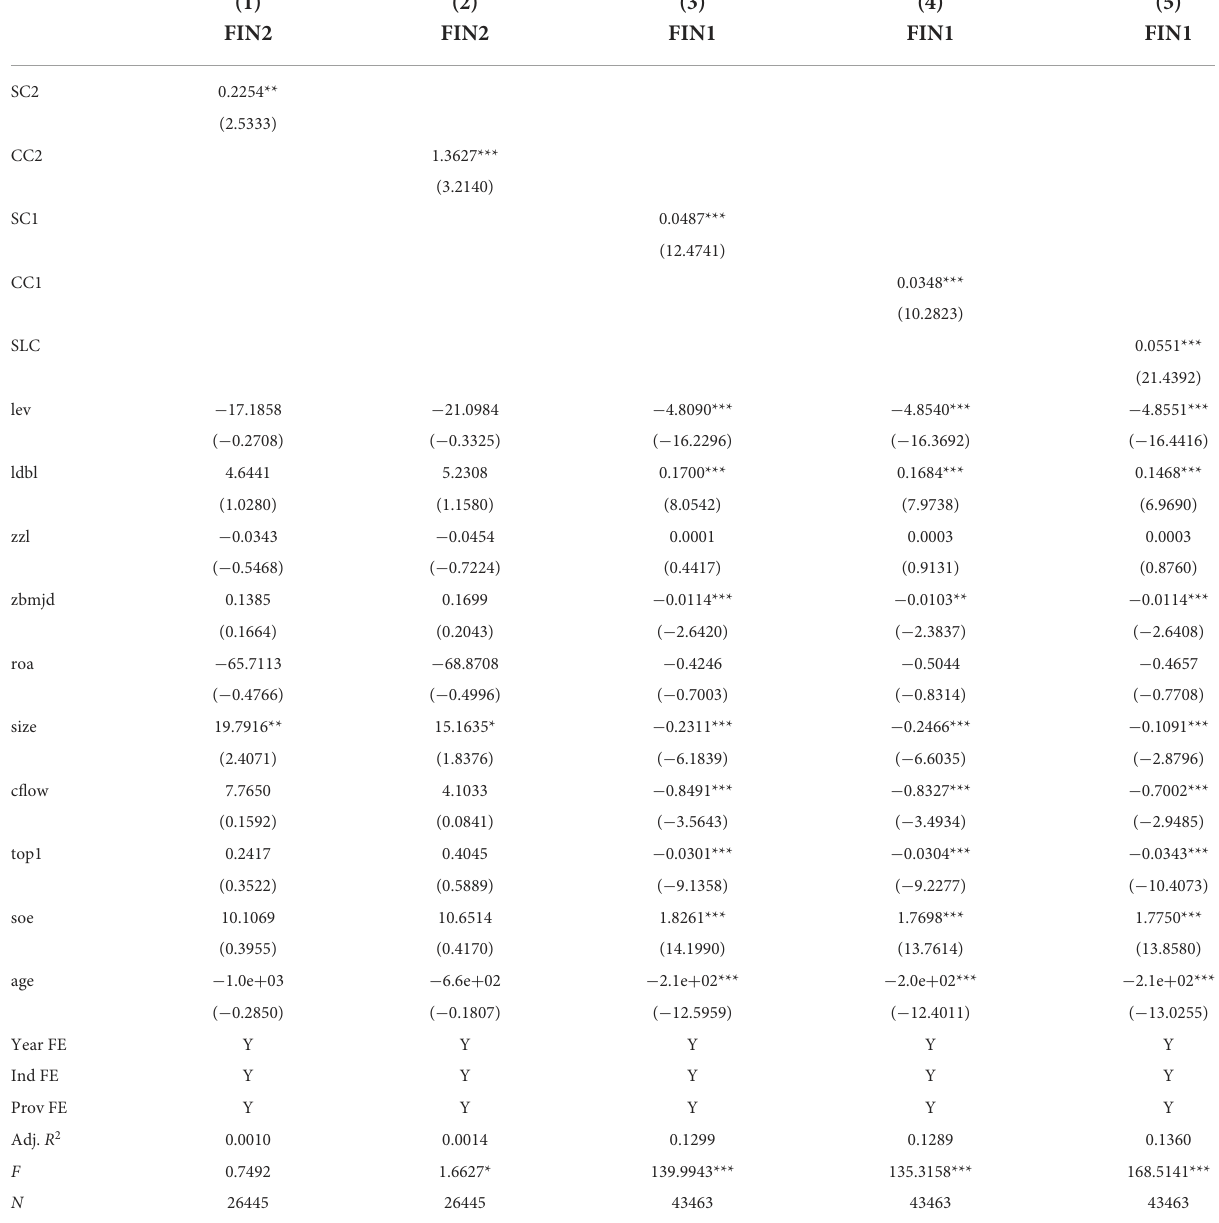
TABLE 9 Alternative independent